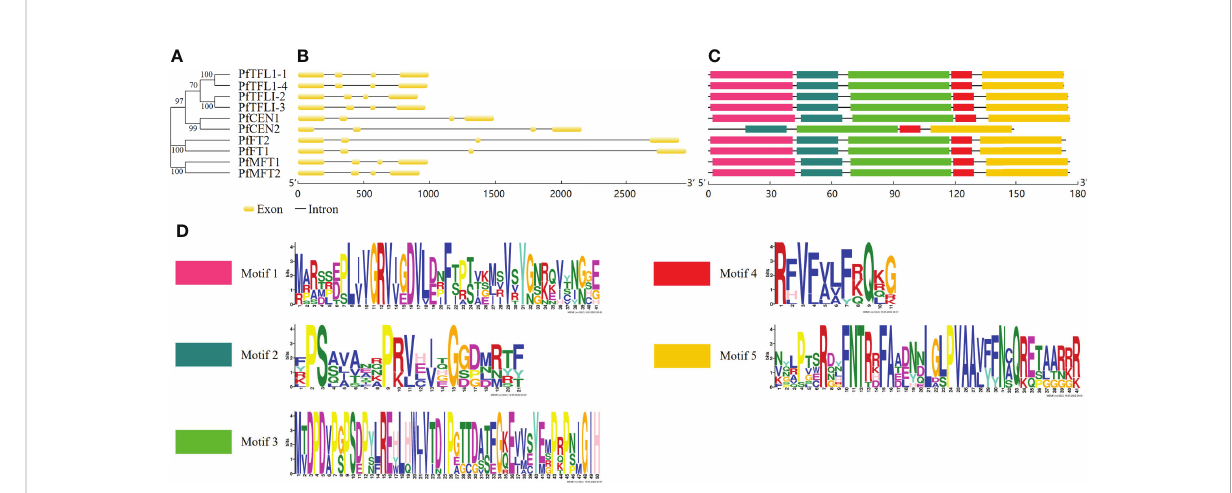
FIGURE 1 Gene structures and motifs of PEBP genes in P. frutescens . (A) The phylogenetic tree was constructed based on amino acid sequences of 10 PfPEBP. (B) Gene structures of PfPEBP genes was constructed using the GSDS 2.0 tools. Yellow boxes indicate exons and black lines represent introns. (C) Motif composition of PfPEBP. The conserved motif numbers in the MEME prediction was set to 5. (D) Sequence logos of fi ve conserved motifs. The overall height of each stack indicates the sequence conservation at that